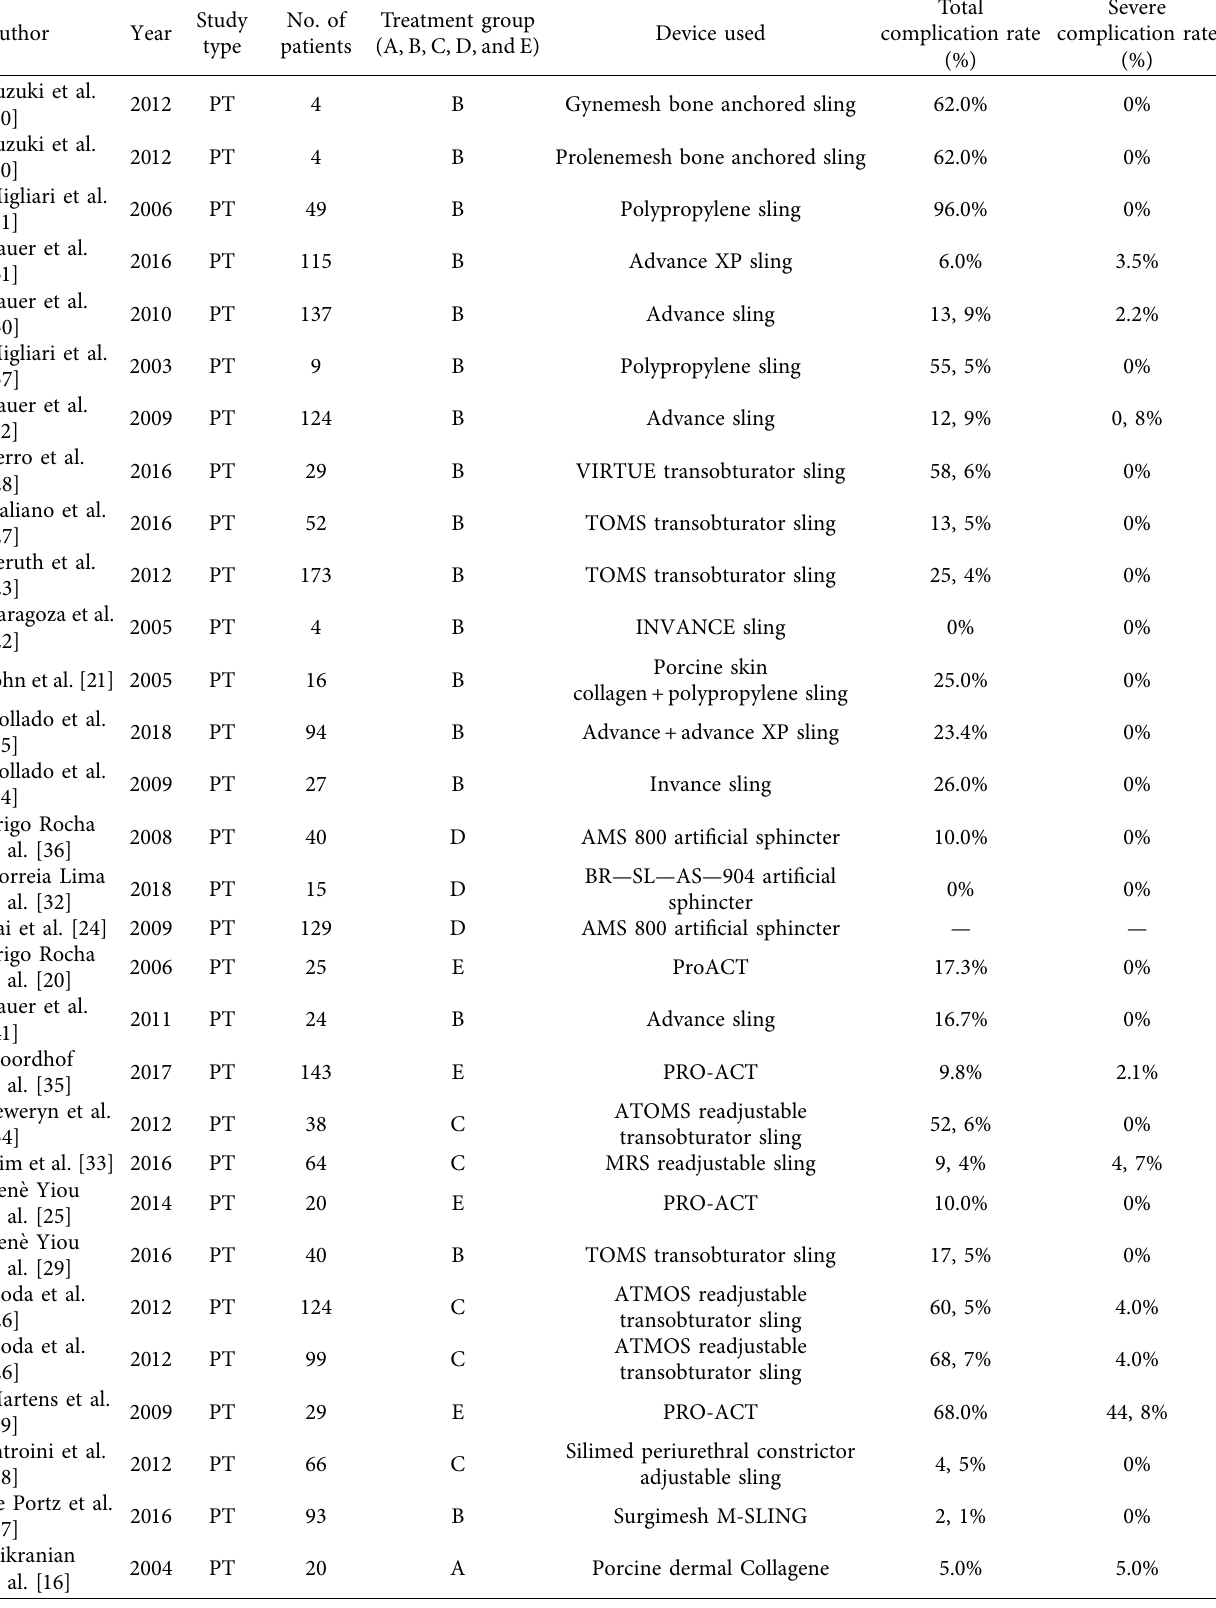
Table 1: 36 prospective clinical trials included in the analysis: main characteristics of the